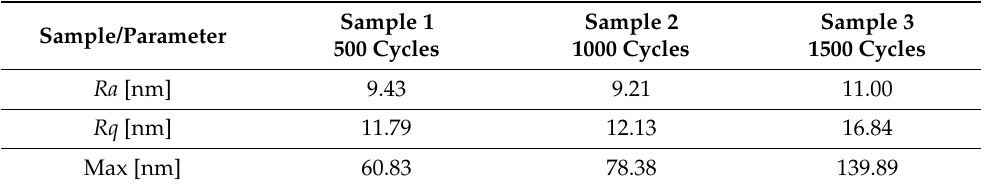
Table 1. Comparison of Ra , Rq parameter values and the maximum height value for three samples with different number of cycles.